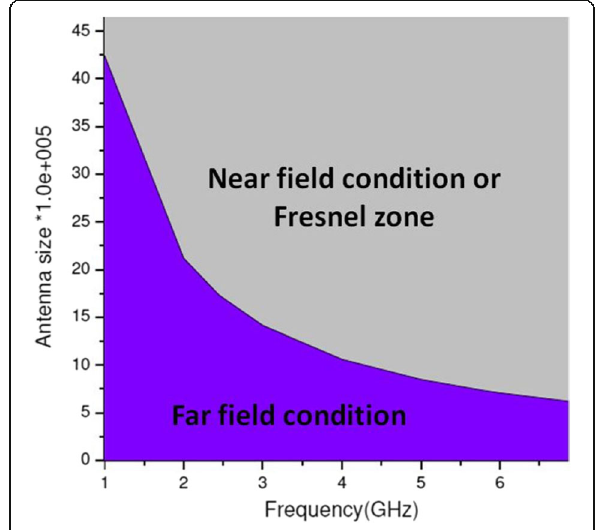
Fig. 5 Antenna size (m 2 ) variation with frequency and near-field region